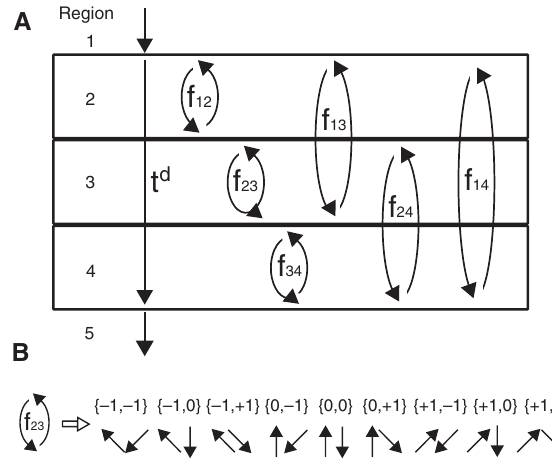
Figure 3: (A) The different loops inside the MIM structure. (B) The expansion of loop f by taking into account the first diffraction 23